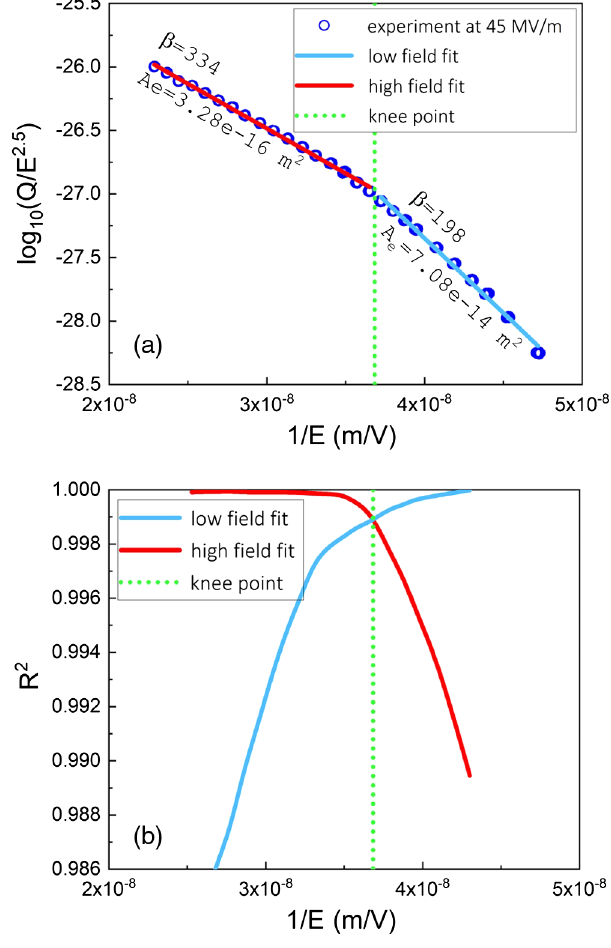
FIG. 6. (a) FN plot and (b) R 2 plot exampled for 45 MV = m. Here, E stands for rf